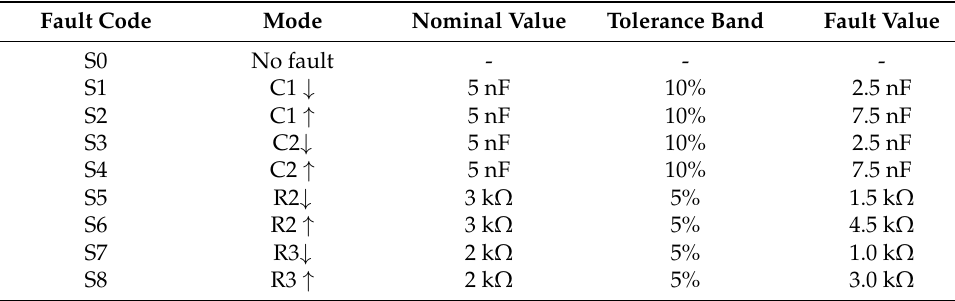
Figure 4. Output signals of different fault patterns in the Salley–Key Bandpass Filter. Table 2. Failure mode of the Shallen–Key bandpass filter